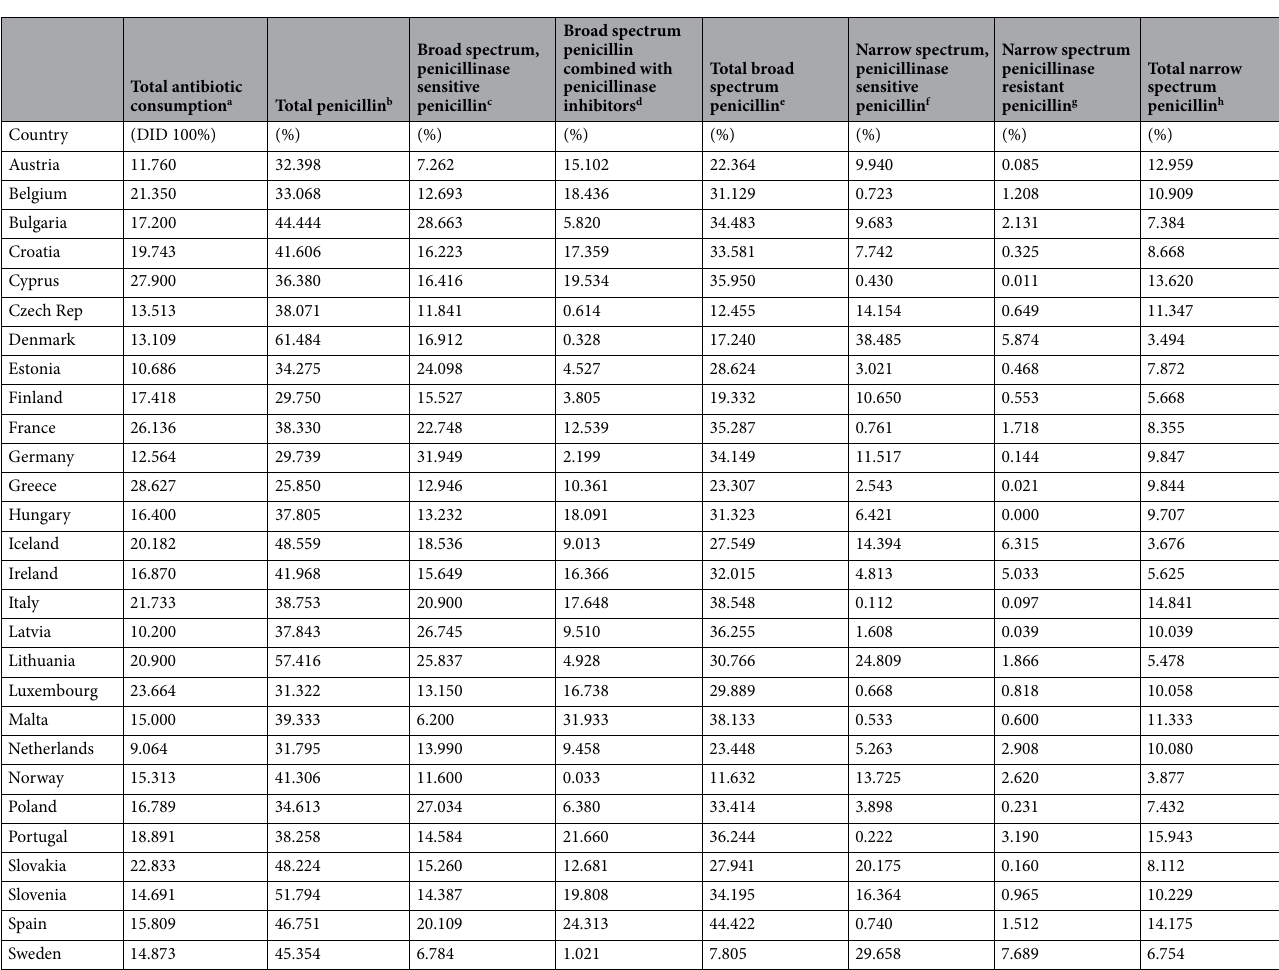
Table 1. Cumulative yearly penicillin consumption (ECDC database 1997–2007). Penicillin consumption (1997–2007), expressed in % of the total consumption (SUM) in DID, according to the ECDC (European Centre for Disease Prevention and Control) database. ATC code: a J01; b J01C; c J01CA; d J01CR; e J01CA + J01CR; f J01CE; g J01CF; h J01CE +